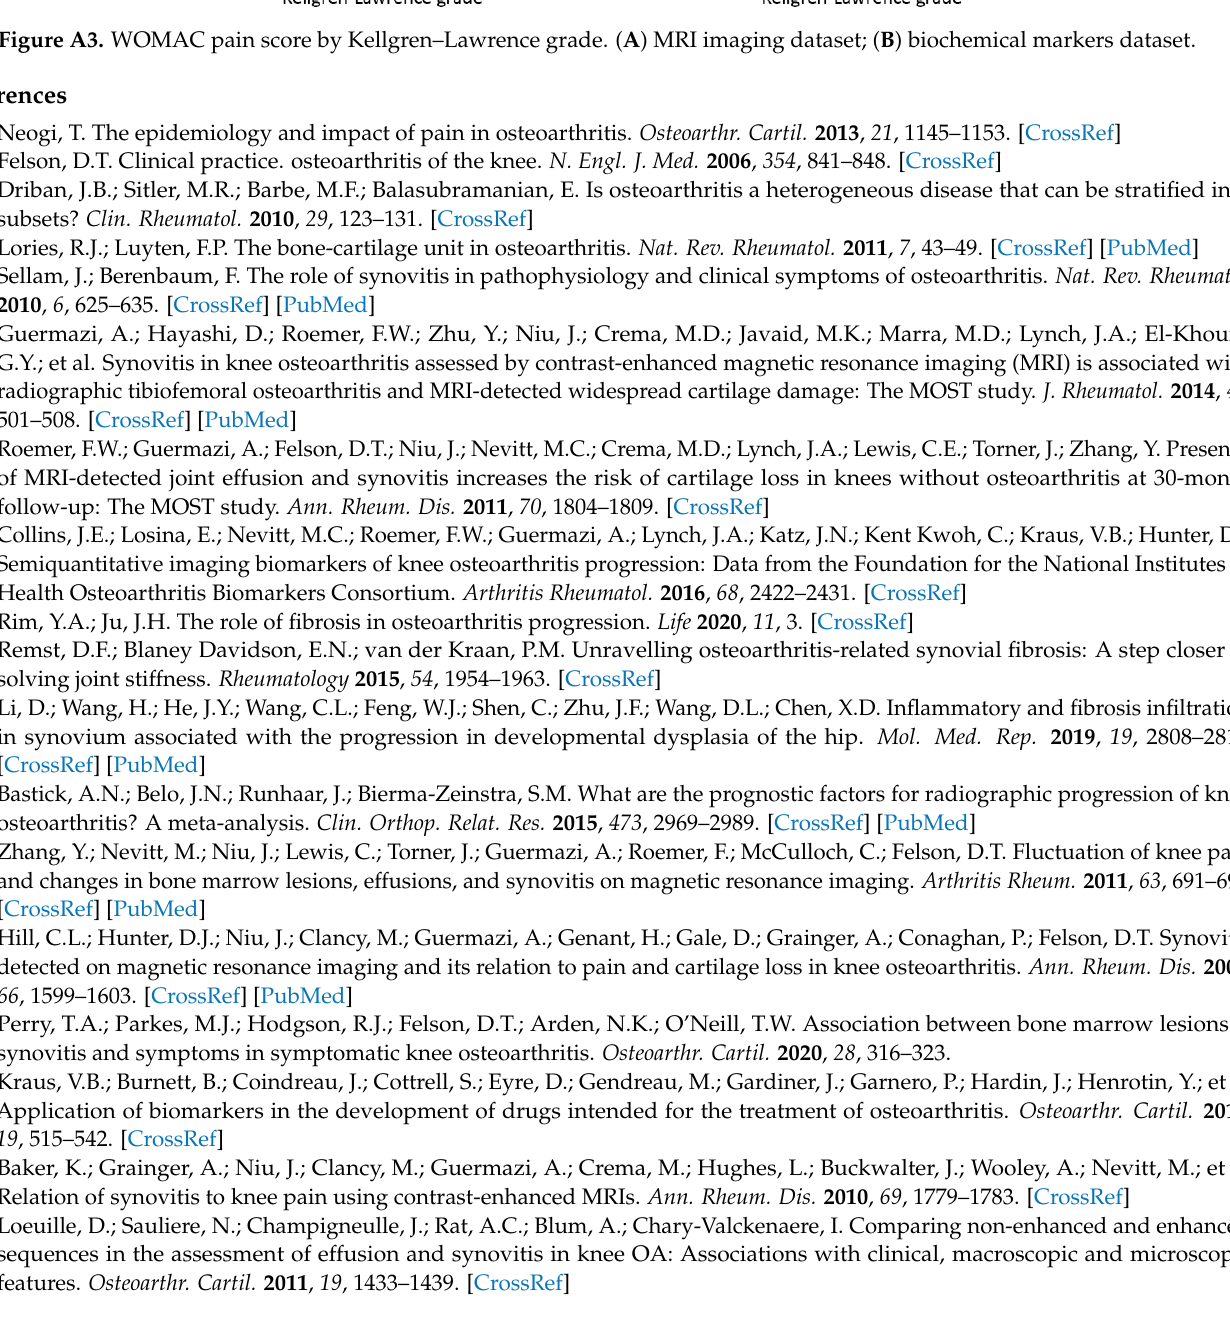
chemical markers dataset.